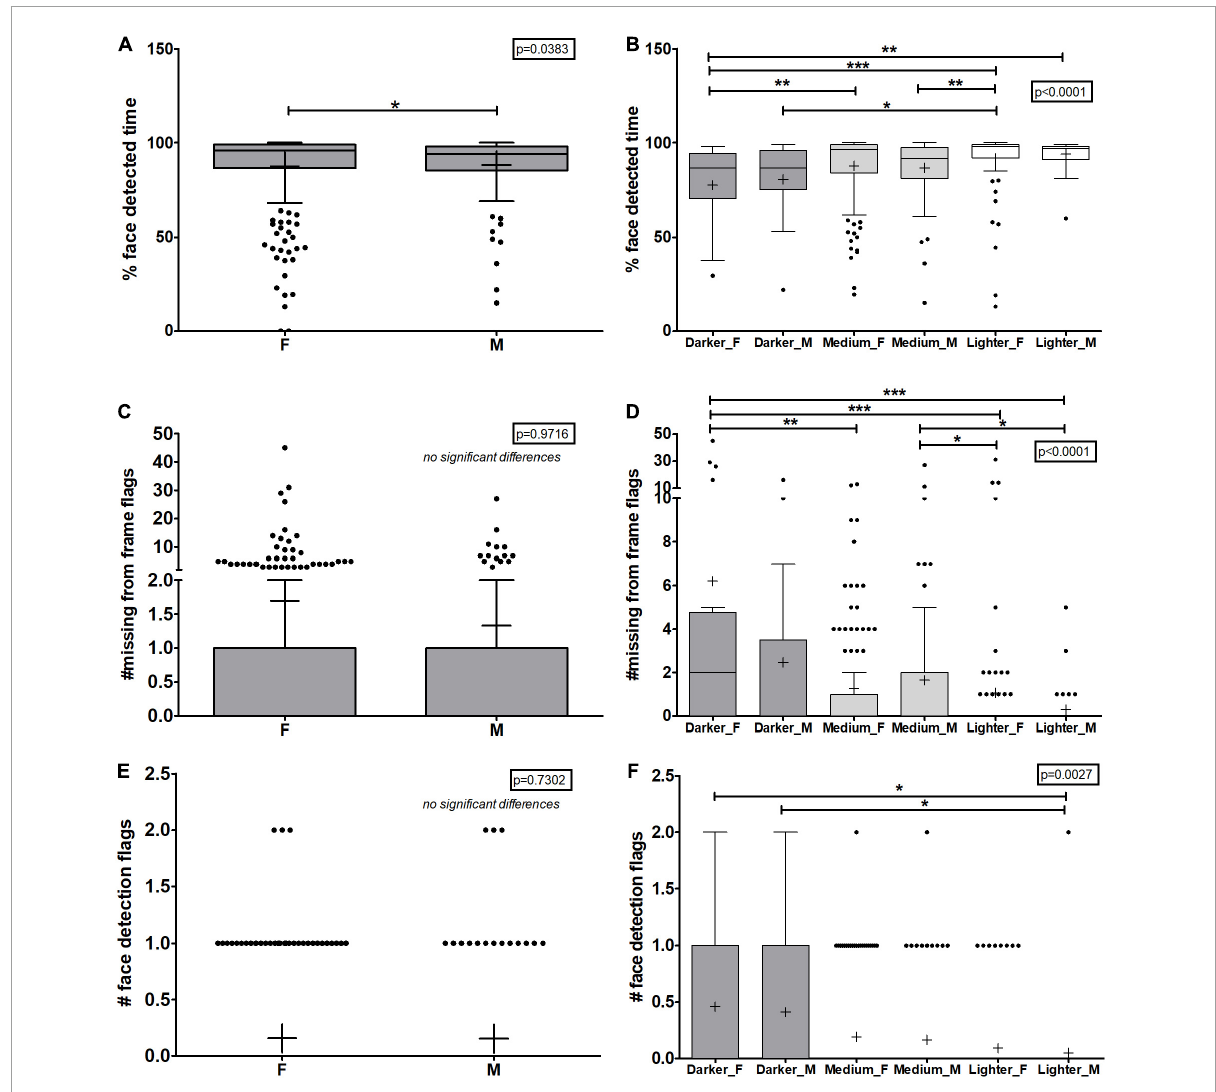
FIGURE5 Face detection metrics by automated test proctoring software based on sex and intersectional data of sex and skin tone. (A,B) The percent facial detection metric (C,D) the number of missing from frame flags given to a student during the assessment, and (E,F) the number of face detection flags for each student are shown. (A,C,E) Show the data based on the self-reported sex of the students. (B,D,F) Show the data based on student’s self-reported sex and skin tone classification. F, female; M, male. Box plots represent 25 and 75% confidence intervals with whiskers represent Tukey’s distributions and dots represent data outliers. Lines inside the boxes represent the median values and + indicate the mean values. Note the divided y -axis scales on some plots to accommodate the wide range of values. Kruskal Wallis non-parametric tests yielded an overall p -values indicated on each plot and Dunn’s post-test pairwise comparisons shown with brackets (* p > 0.05, ** p < 0.01, *** p <